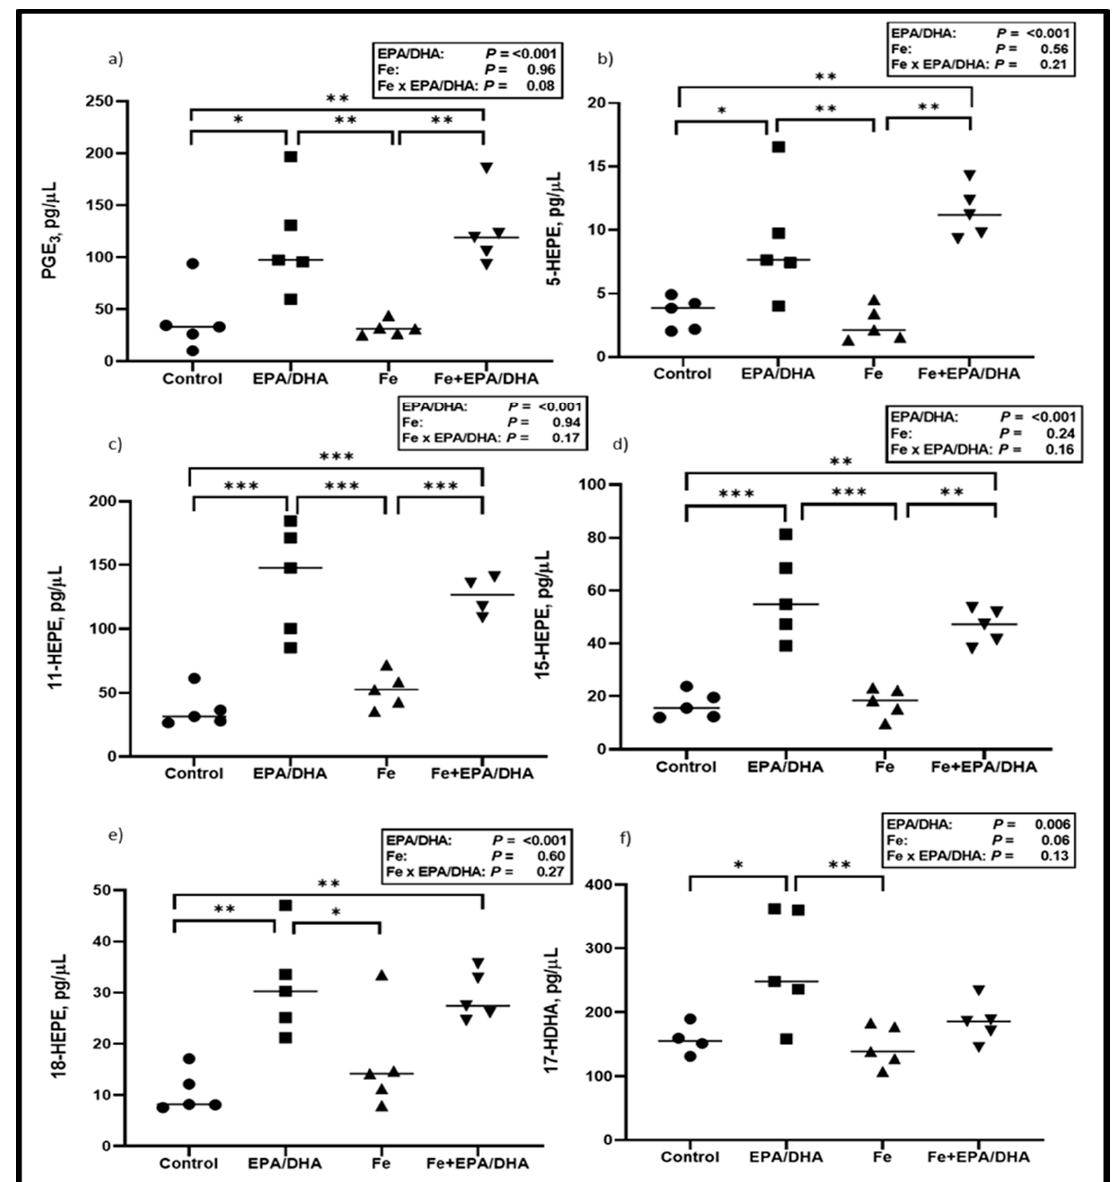
Figure 4. Lipid mediator concentrations including ( a ) PGE 3 , ( b ) 5-HEPE, ( c ) 11-HEPE, ( d ) 15-HEPE, ( e ) 18-HEPE and ( f ) 17-HDHA after providing Mtb -infected mice with control, EPA / DHA, Fe, or Fe + EPA / DHA diets for three weeks. Results repeated in two experiments, data shown for one experiment ( n = 5 per group). Two-way ANOVA was used to test e ff ects of EPA / DHA (control & Fe vs. EPA / DHA & Fe + EPA / DHA), Fe (control & EPA / DHA vs. Fe & Fe + EPA / DHA), and Fe × EPA / DHA interactions. One-way ANOVA followed by Tukey post-hoc test was used to